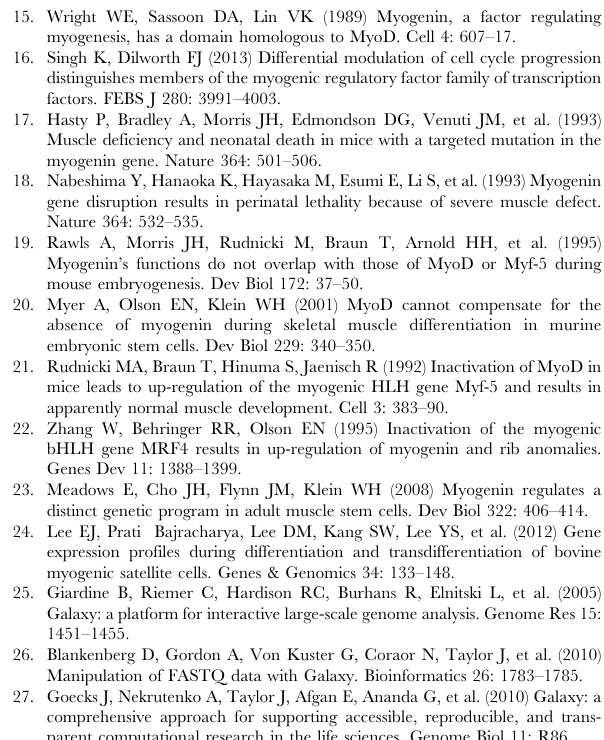
Figure S1 Pax7 expression in MSCs. Cellular localization of Pax7 on MSCs at Day 10 by immunocytochemistry. A ) Cell picture B ) DAPI-stained nuclei. C ) Pax7 antibody stained cells. (TIF) Figure S2 Multiple sequence alignment of LYL1 and other bHLH genes. Multiple sequence alignment of LYL1 (UNIPROT ID: E1BAR3) protein and other bHLH proteins (MyoD, MyoG, Myf5, and herculin) which are involved in skeletal muscle development. The region in the box indicates high sequence similarity in the bHLH region of these muscle specific proteins. (TIF) Figure S3 Other muscle specific pathways affected by MYOG kd . A ) WNT signaling pathway, B ) Focal adhesion, C ) TGF-beta signaling pathway, D ) Hippo signaling pathway, E) PPAR signaling pathway. (PDF) Table S1 Primer information. (XLSX)